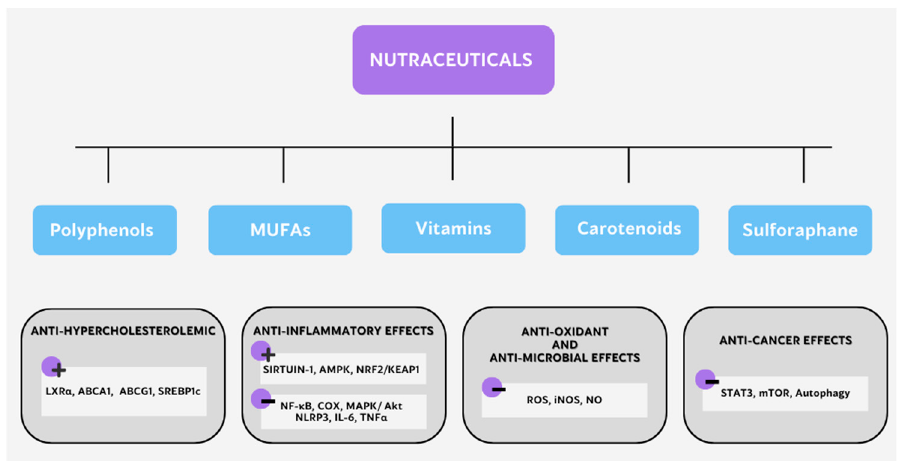
Figure 3. Different mechanisms of action of nutraceuticals with immunometabolic potential.